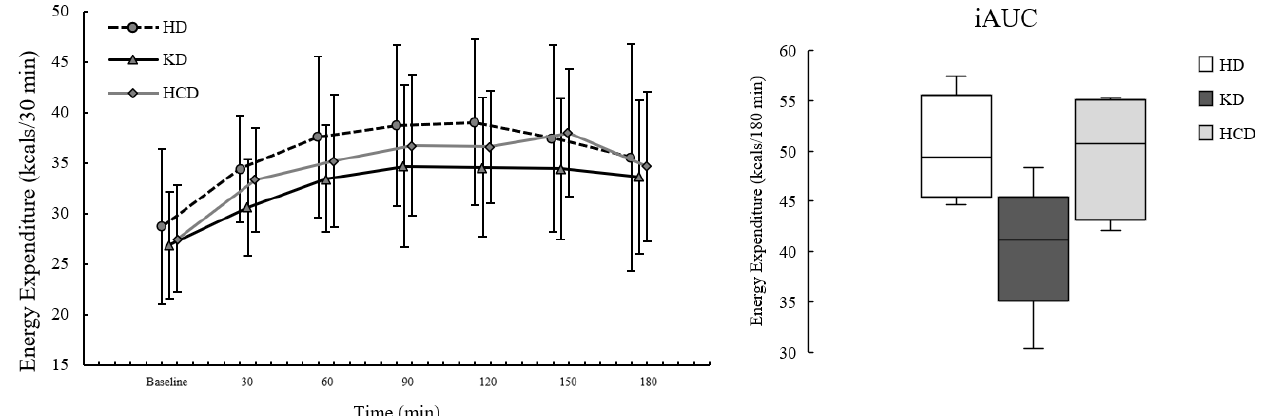
Figure 1. Postprandial energy expenditure (EE) following a ketogenic meal (KD), a high-carbohydrate meal (HCD), and a habitual meal (HD). Each point on the line graph is plotted as mean and standard deviation. The boxplots represent the incremental area under the curve (iAUC) where the line within each box represents the 50th percentile; the upper and lower limits of each box represent the 25th and 75th percentile; and the upper and lower error bars representing the 10th and 90th percentile. There were no significant effects between condition and time or for iAUC ( p < 0.050). iAUC: incremental area under the curve; HD: habitual diet meal; KD: ketogenic diet meal; HCD: high-carbohydrate